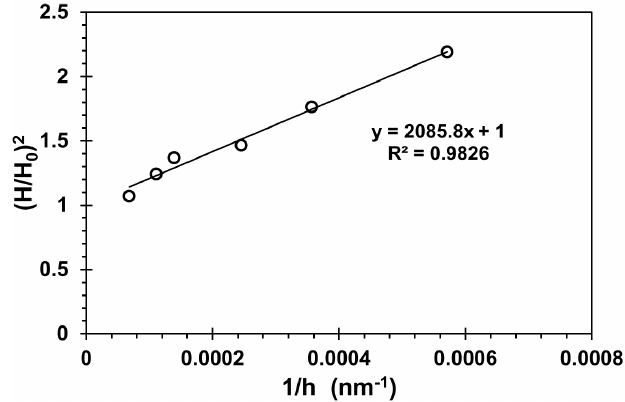
Figure 3. Indentation size effect and fitting of Equation (1) for the X52 steel.